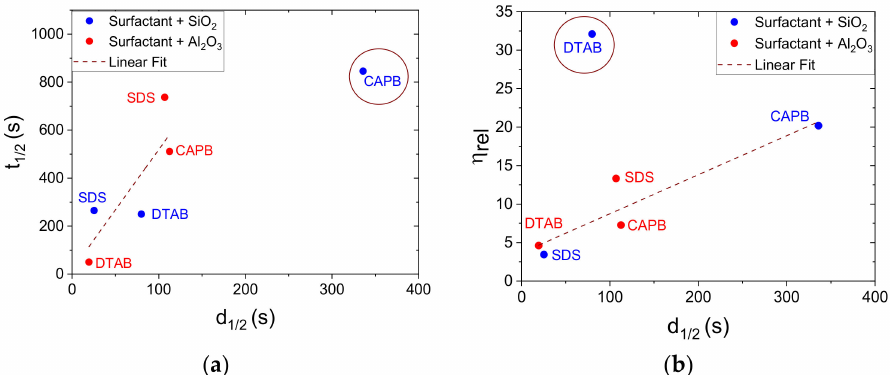
Figure 6. ( a ) Correlation between foam half-life ( t 1/2 ) and drainage half-life ( d 1/2 ). ( b ) Correlation be- tween bulk relative viscosity ( η rel ) and drainage half-life ( d 1/2 ) of CO 2 foams formed with surfactants in the presence of 1.0 wt % NPs. (The lines are a guide for the eyes.)